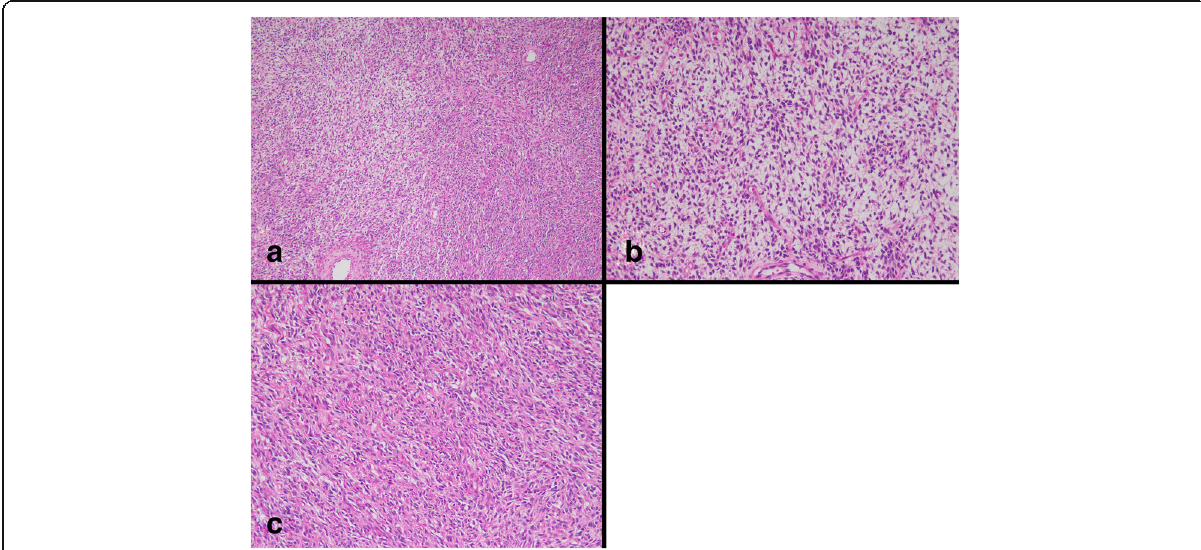
Fig. 1 Histopathological findings of the right ovarian tumor harvested 18 years prior. a Low-power view. b Growth of theca cell-like cells.